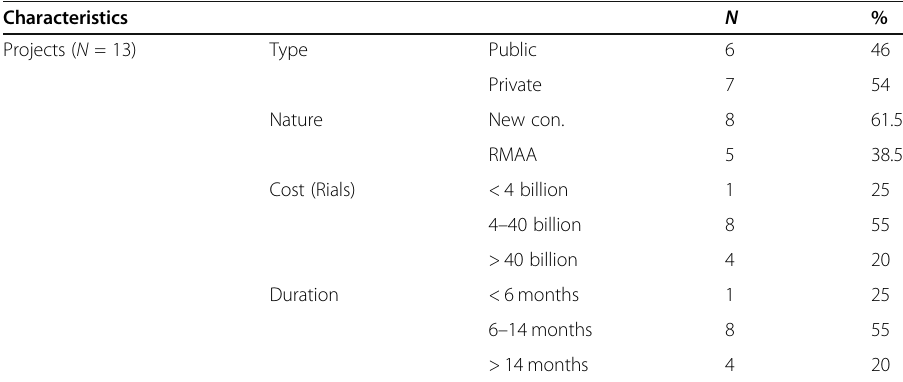
Table 5 Projects characteristics having RM system by each companies